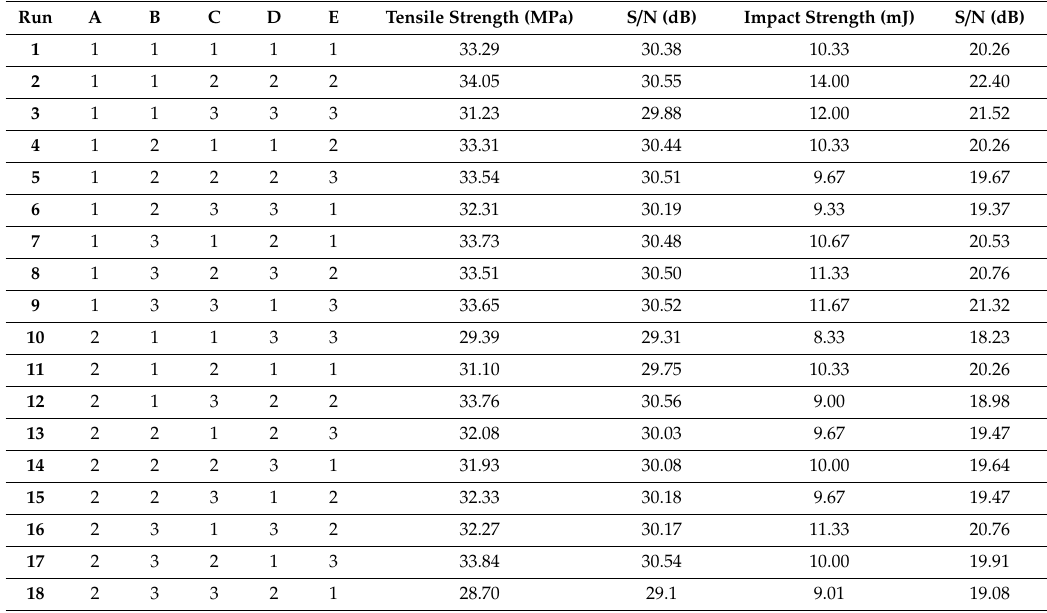
Table 2. L18 array used for the experiments.